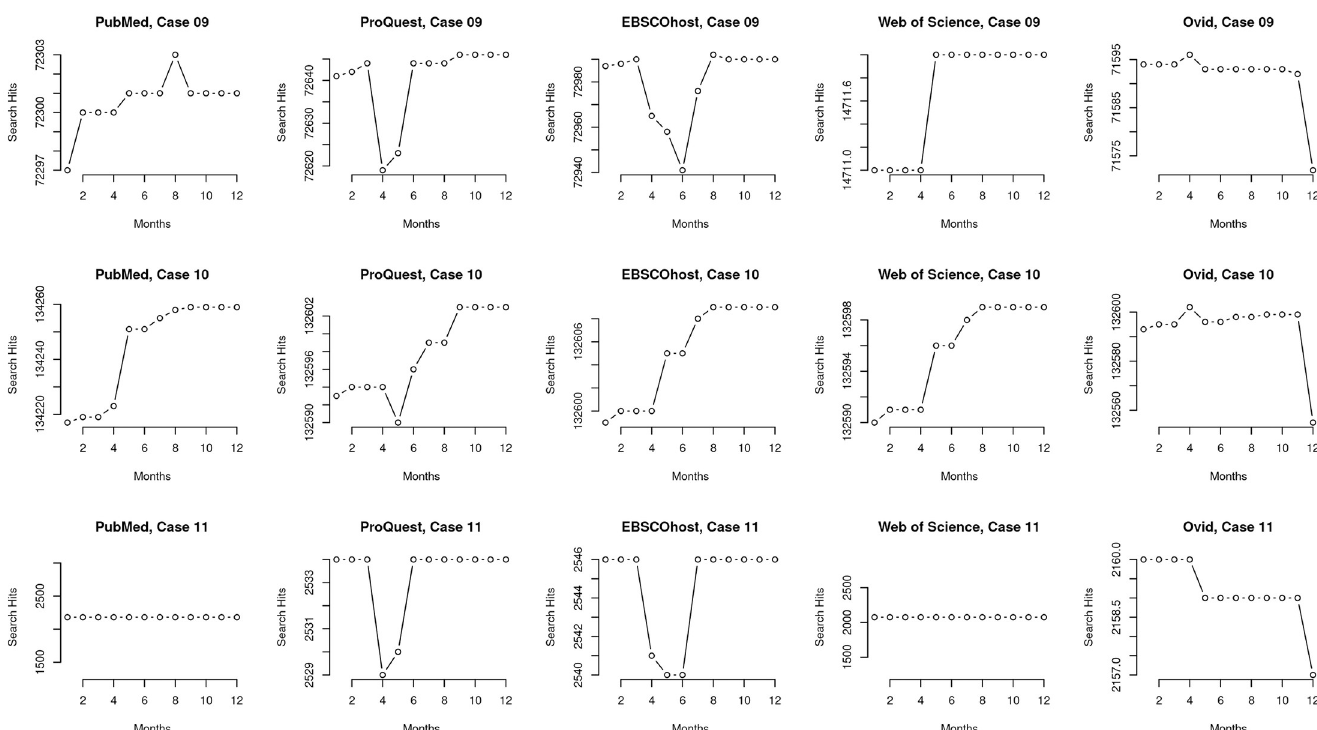
Fig 6. Micro view of cases #03–#11. A micro perspective of search result counts for cases #03-#11 that were restricted by publication date. Each row displays all five platforms individually within a case to aid side by side comparison of results. The micro perspective is able to show how the platforms vary in detail and trends; most importantly, they highlight different trajectories and differences in how platforms drop retrieved records even for publications with publication dates ending years before data collection.